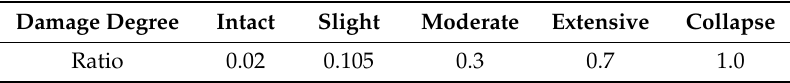
Table 4. The ratio of the failure loss expectation to the initial cost of the structure at different damage